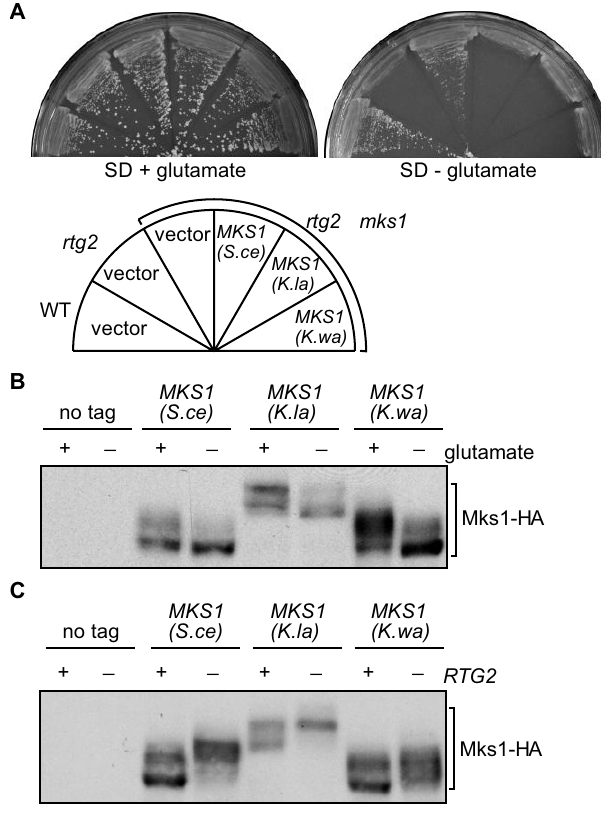
Figure 4. The function and regulation of Mks1 homologs from K. lactis and K. waltii are conserved. (A) MKS1 homologs from K. lactis ( K.la ) and K. waltii ( K.wa ) complement an mks1 (cid:39) mutation in S. cerevisiae ( S.ce ) . Yeast strains as indicated were grown on SD medium with or without glutamate at 30 °C for 2 to 3 days. ( B ) Glutamate has similar effects on the phosphorylation of S. cerevisiae Mks1 and its homologs from K. lactis and K. waltii . mks1 (cid:39) mutant cells (ZLY028) carrying centromeric plasmids encoding MKS1 genes from the indicated fungal species were grown in SD medium supplemented with or without glutamate. Total cellular proteins were prepared and separated by SDS-PAGE, and HA-tagged Mks1 was detected by Western-blotting. ( C ) The absence of RTG2 increases phosphorylation of Mks1. Cells expressing HA-tagged Mks1 from the indicated fungal species without ( + RTG2 ) or with an rtg2 (cid:39) mutation ( (cid:0) RTG2 ) were grown in YNBcasD medium, and phosphorylation of Mks1 was analyzed as described for panel